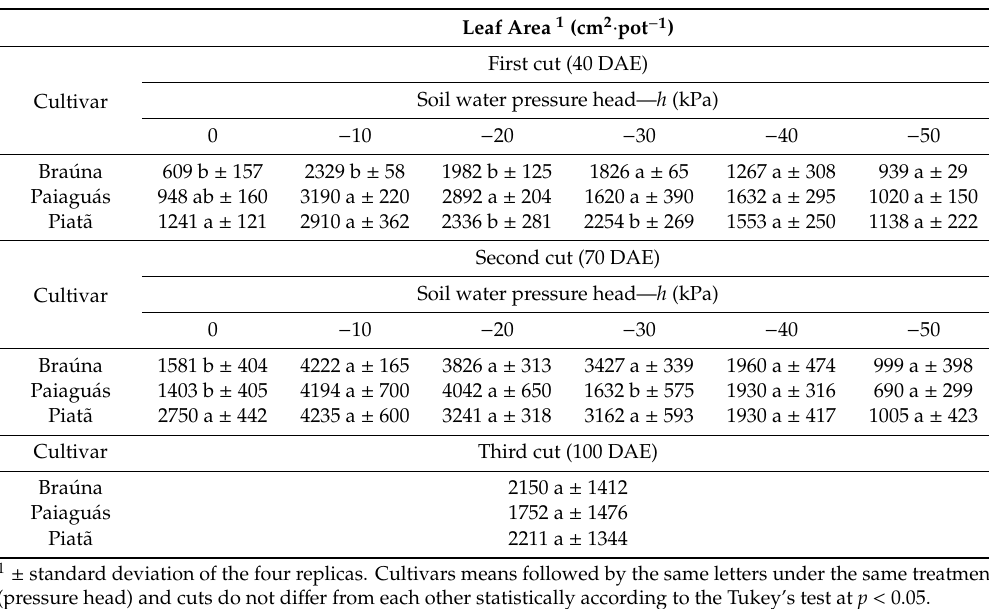
Table 3. Effect of soil water pressure head on leaf area ( Brachiaria brizantha cultivars) for the three cutting periods.